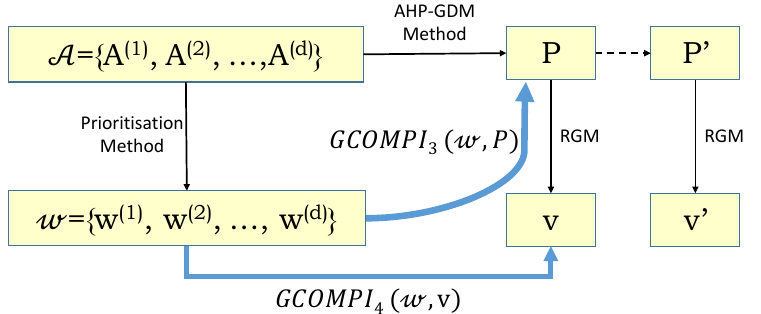
Figure 3. Outline of the incompatibility reduction of indicators GCOMPI 3 and GCOMPI 4